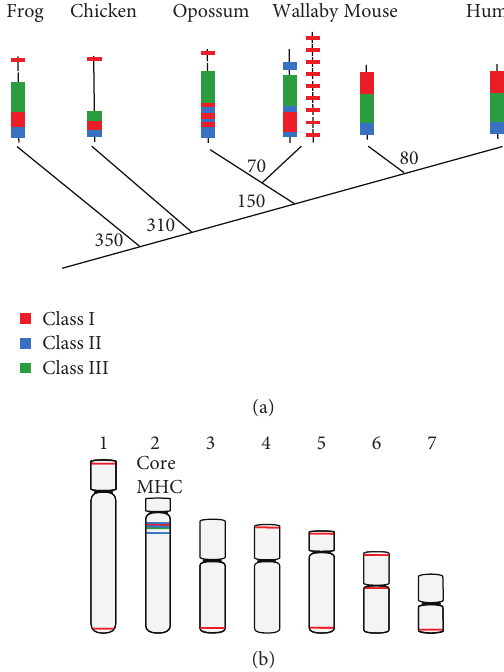
F 2: MHC organisation. (a) A comparison of MHC organi- sation across different vertebrate lineages. e organisation of the opossum MHC resembles the ancestral organisation observed in frog and chicken, and the organisation in human and mouse is derived (modi�ed from [43]). (b) e tammar wallaby core MHC region is substantially different to that of the opossum, with Class II genes on either side of the Class III region and Class I genes distributed on different